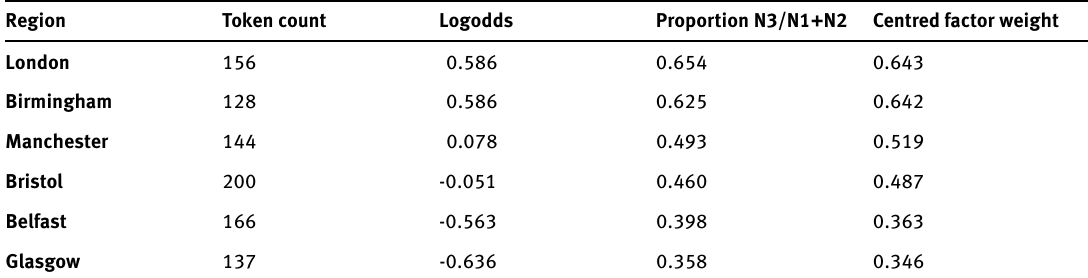
Table 7: Mixed effects variable rule analysis of N3 v N1+N2, interaction with region Region